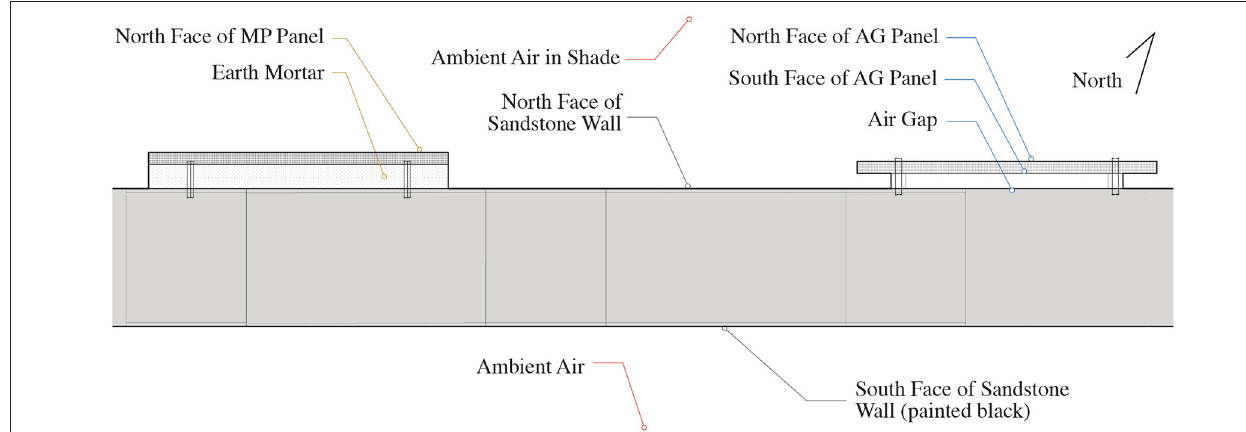
FIGURE 5 | Bhuj, India test wall plan section.